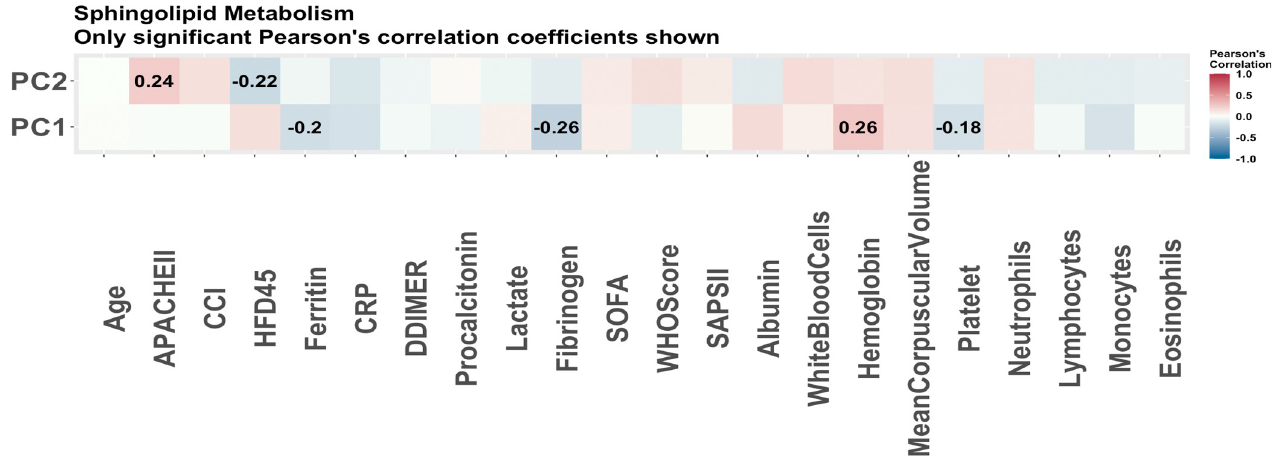
Fig 8. The Pearson correlations of principal components of pathways associated with disease severity (all patients). The Pearson correlations of clinical covariates and the principal components used to summarize the enriched pathways with disease severity using all patients as predicted by LIPEA. These are the pathways predicted to be enriched based on the 11 lipids determined to be associated with disease severity via stability selection which were able to be mapped to known pathways. Only the correlations which were significant (p-value < 0.05) are reported. The strongest correlations are with fibrinogen and